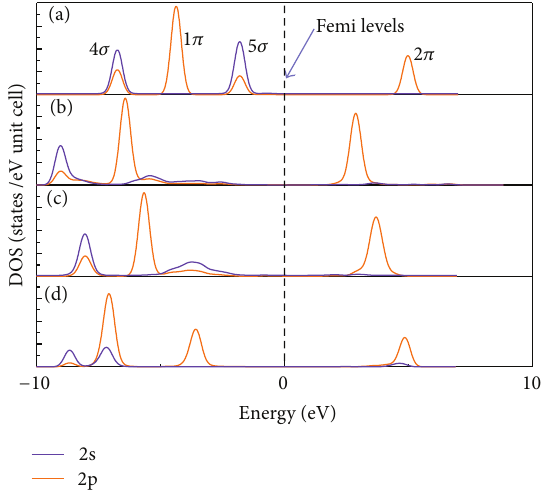
Figure 10: DOS of pure, Pt-, Fe-, and Zn-doped SnO 2 (110) surfaces.